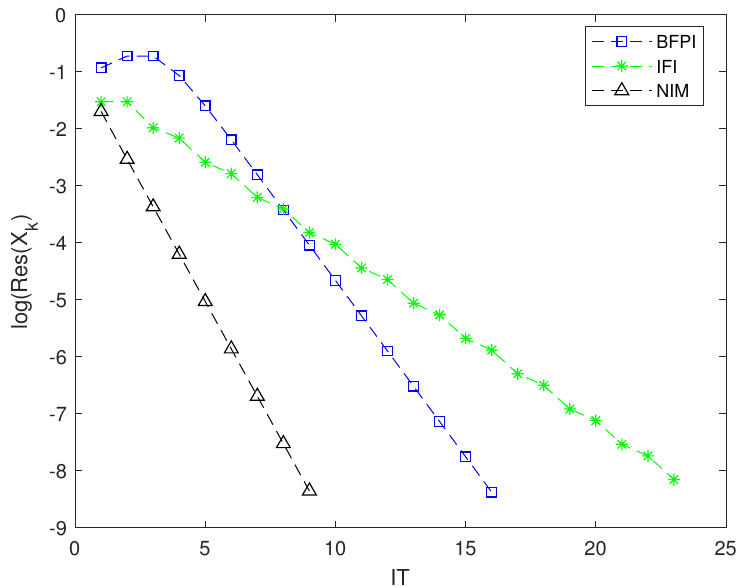
Figure 2. The convergence process of the three iterations for computing Equation (1) for Example 2.